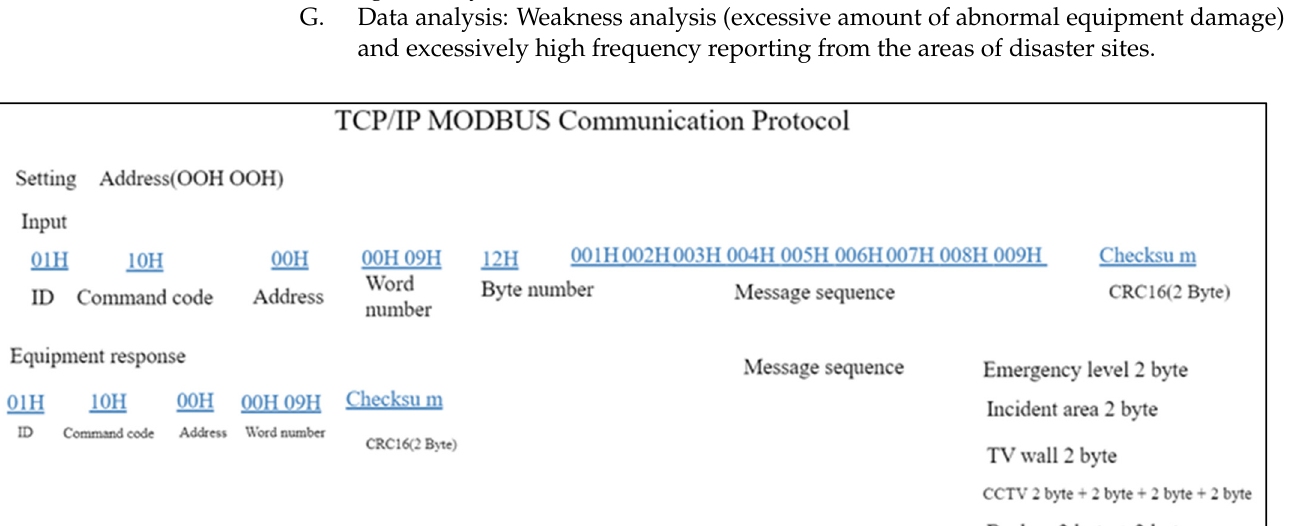
Figure 4. Communication protocol. (Source: Taipei Main Station Intelligent Joint Disaster Prevention Center, 2022).